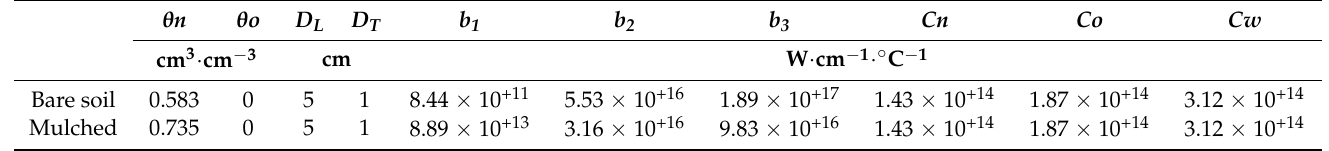
Table 3. Model parameters to simulate soil heat